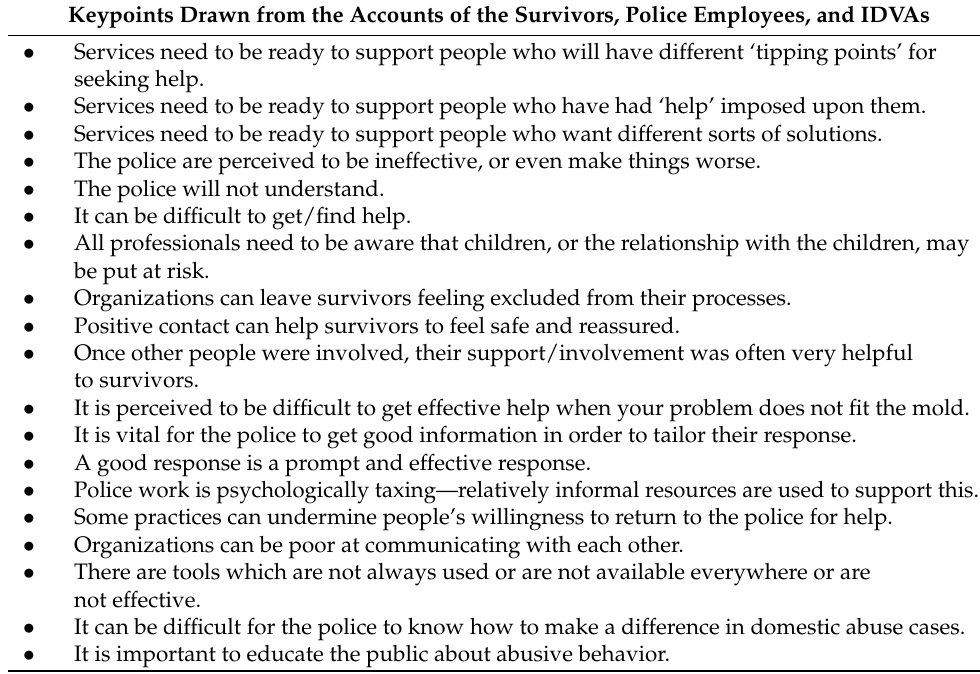
Table 1. List of the keypoints drawn from the accounts of the participants 1 . Keypoints Drawn from the Accounts of the Survivors, Police Employees, and